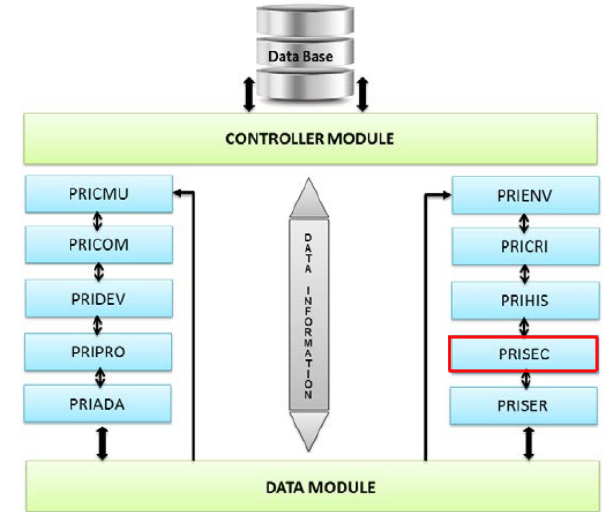
Figure 1. (Ubiquitous privacy) UbiPri privacy modules, Leithardt et al.